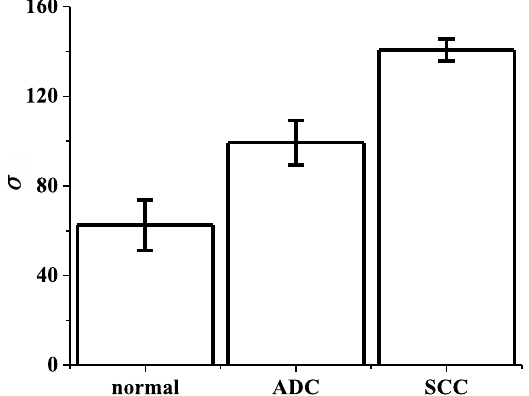
Fig. 4. The increase of (cid:1) of the spatial frequency spectra as a function of brain tissue type including normal brain tissue and brain metastases from lung cancers: ADC and